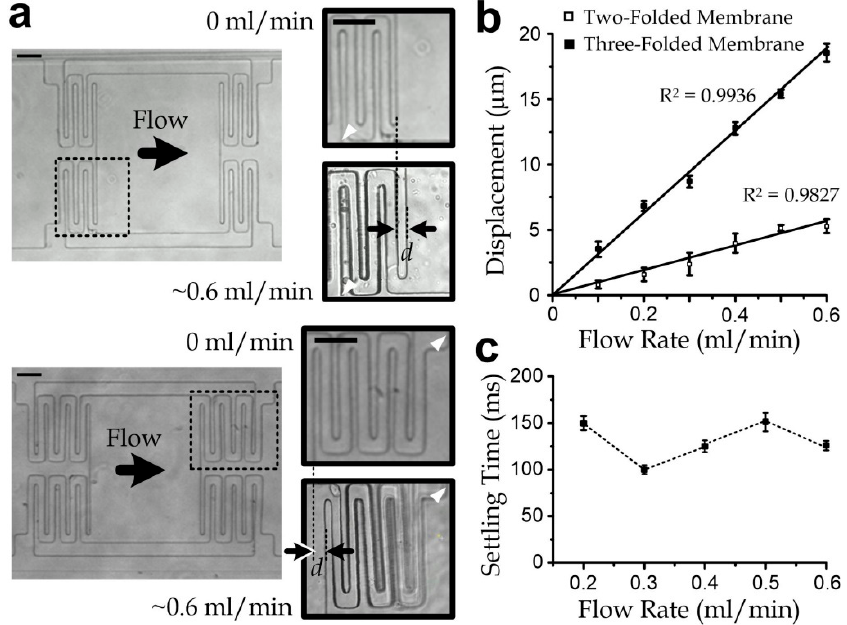
Figure 3. ( a ) Microscopic images of the two ‐ folded and three ‐ folded membranes. Inset: magnified microscopic images of the folded beam regions highlighted by the dotted boxes for the cases of no flow and flowing mineral oil at a flow rate of ~0.6 mL/min. The membrane displacements are denoted as ‘ d ’. White arrows indicate the anchor positions. All scale bars: 50 μ m. ( b ) Comparison of the membrane displacements of the two ‐ folded and three ‐ folded designs under different flow rates of mineral oil. ( c ) Settling time of the membrane displacement under flow rates of mineral oil up to 0.6 mL/min. All error bars in this figure are standard errors ( N ≥ 5).